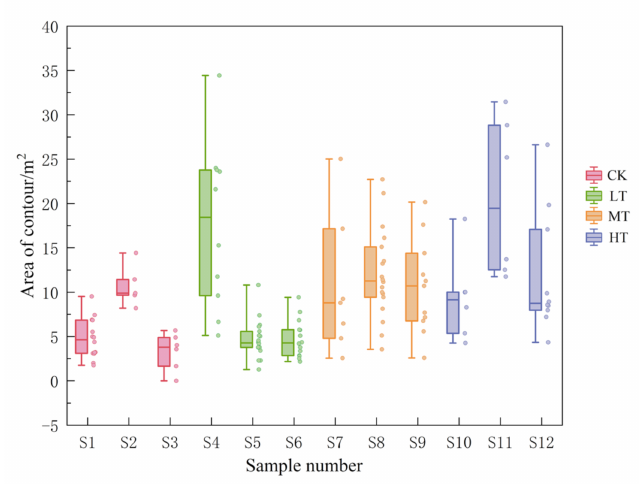
Figure 3. The effect of thinning on A -index under different treatments. The CK treatment included plots S1~S3, the LT treatment included plots S4~S6, the MT treatment included plots S7~S9, and the HT treatment included plots